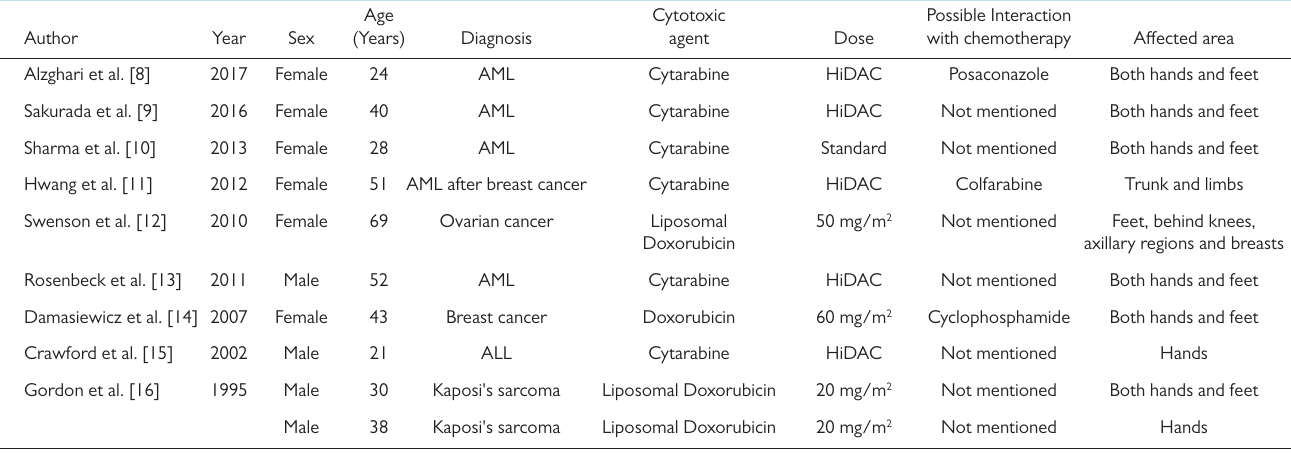
Figure 1. Palmoplantar Erythrodysesthesia Syndrome in both hands following induction regimen for treating acute myeloid leukemia (AML). Table 1. Previous cases of PPES induced by Cytarabine or Doxorubicin